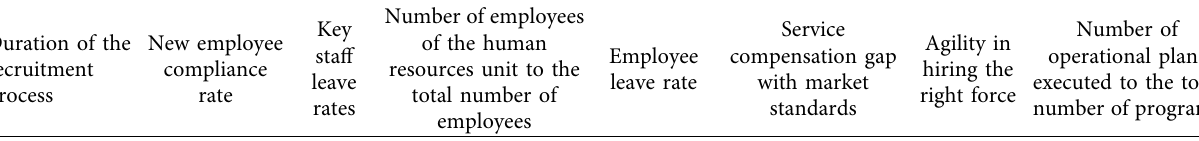
Table 10: Weights obtained from the hierarchical analysis process in terms of internal processes.